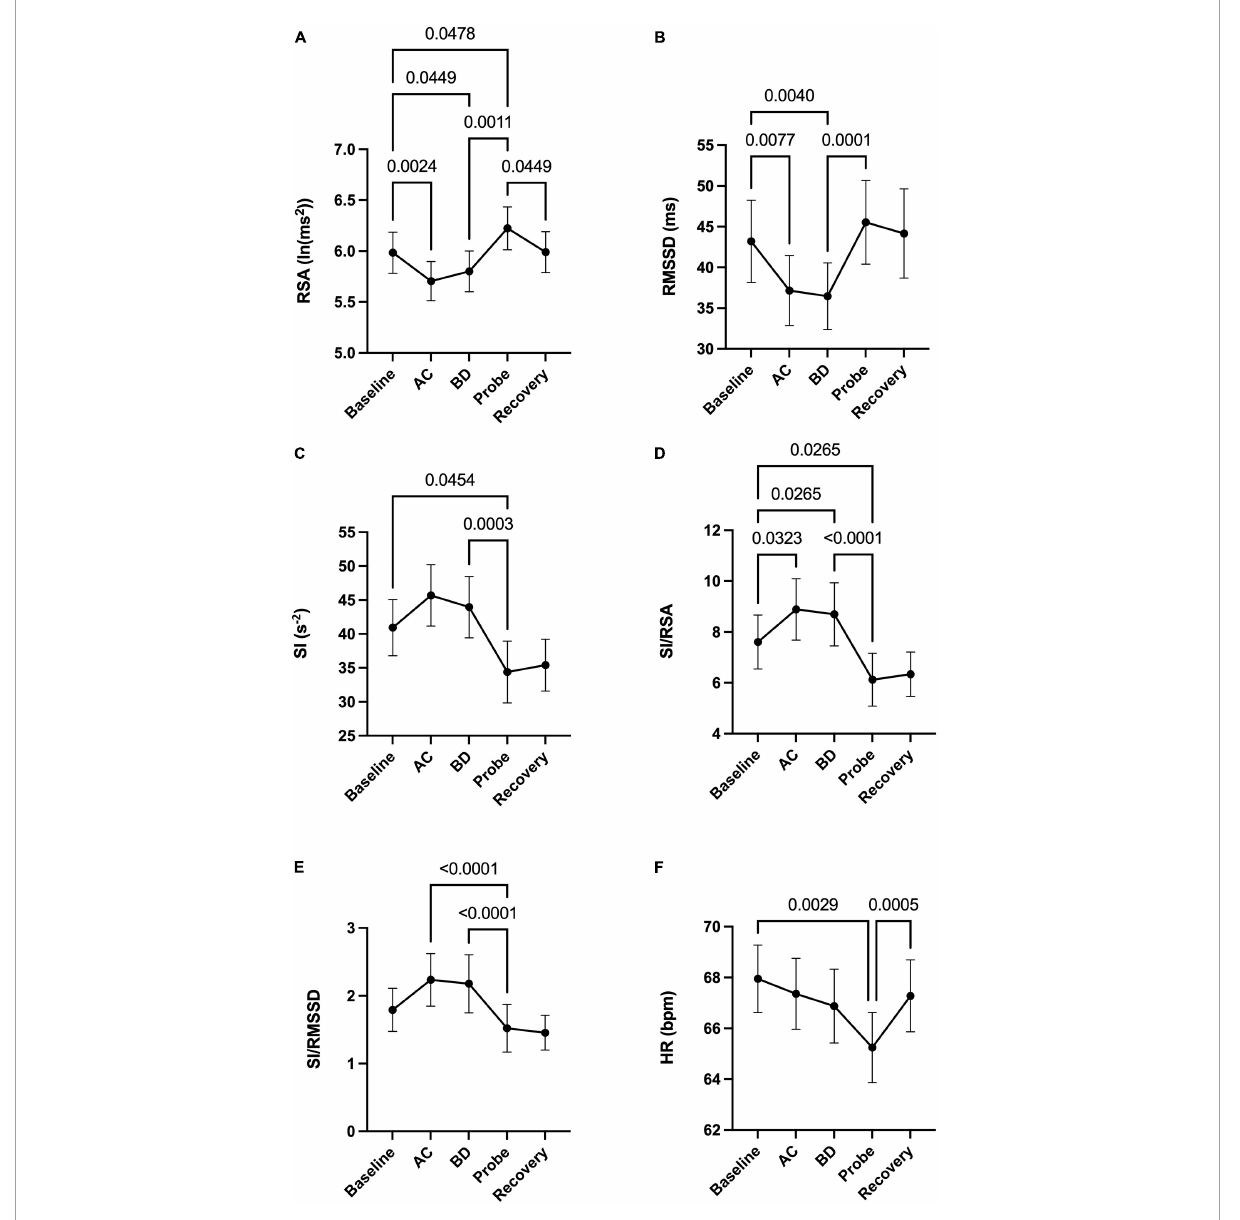
FIGURE2 Autonomic nervous system modulation as deduced from HRV changes during one session of low-level laser therapy, stimulating the lumbar and sacral spine. (A) RSA, (B) RMSSD, (C) SI, (D) SI/RSA, (E) SI/RMSSD, (F) HR. Average values ± SEM from 41 patients with chronic colonic motility